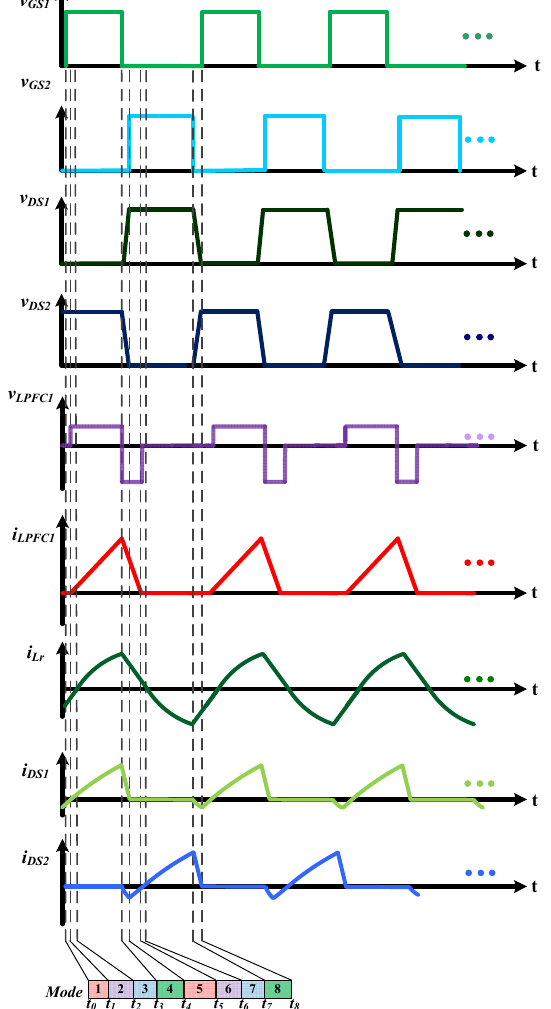
Figure 4. Key waveforms of the presented LED tube lamp driver during the positive half ‐ cycle of the input utility ‐ line voltage.